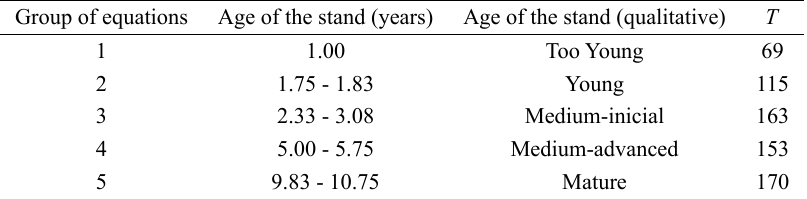
Group and systems of equations arranged by age and maturity of the forests and numbers of trees sampled ( T ) in stands of black wattle in the state of Rio Grande do Sul, Brazil. Group of equations Age of the stand (years) Age of the stand